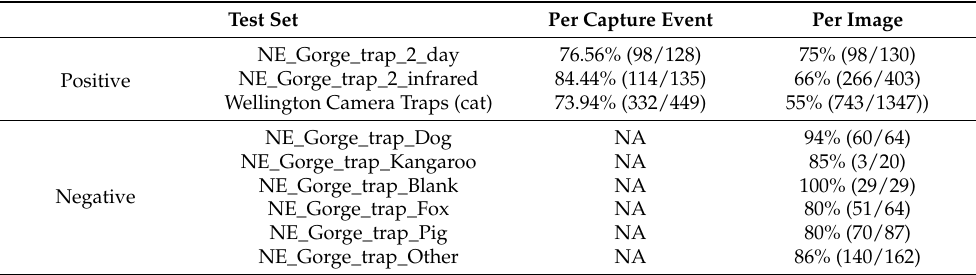
Table 3. Performance of felis_catus_detector on images containing cats ranged from 55–75% accuracy when calculated on a per image basis. Performance was significantly better when evaluated on a per capture event basis (73.94–84.44%), which is more useful in for practical purposes. The model performed well on negative samples, with 80–100% of images being correctly